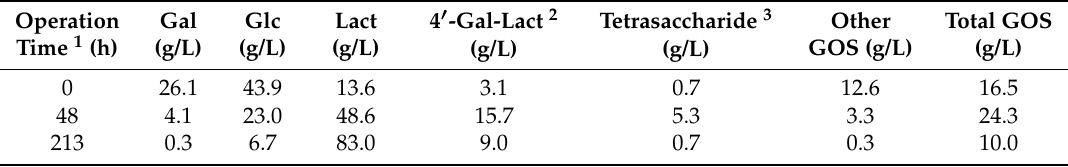
Table 1. Composition of the reaction mixtures at the beginning of operation (0 h), maximum GOS (galactooligosaccharides) concentration (48 h) and at the end of operation (213 h).